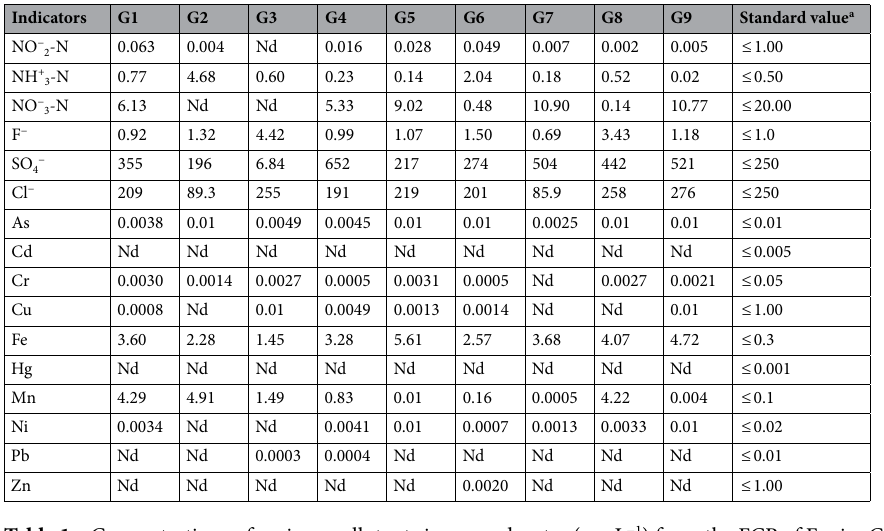
Table 1. Concentrations of various pollutants in ground water (mg·L −1 ) from the FCP of Fuxin, China. a Standard value from GB/T14848-2017 (Class III). Nd not